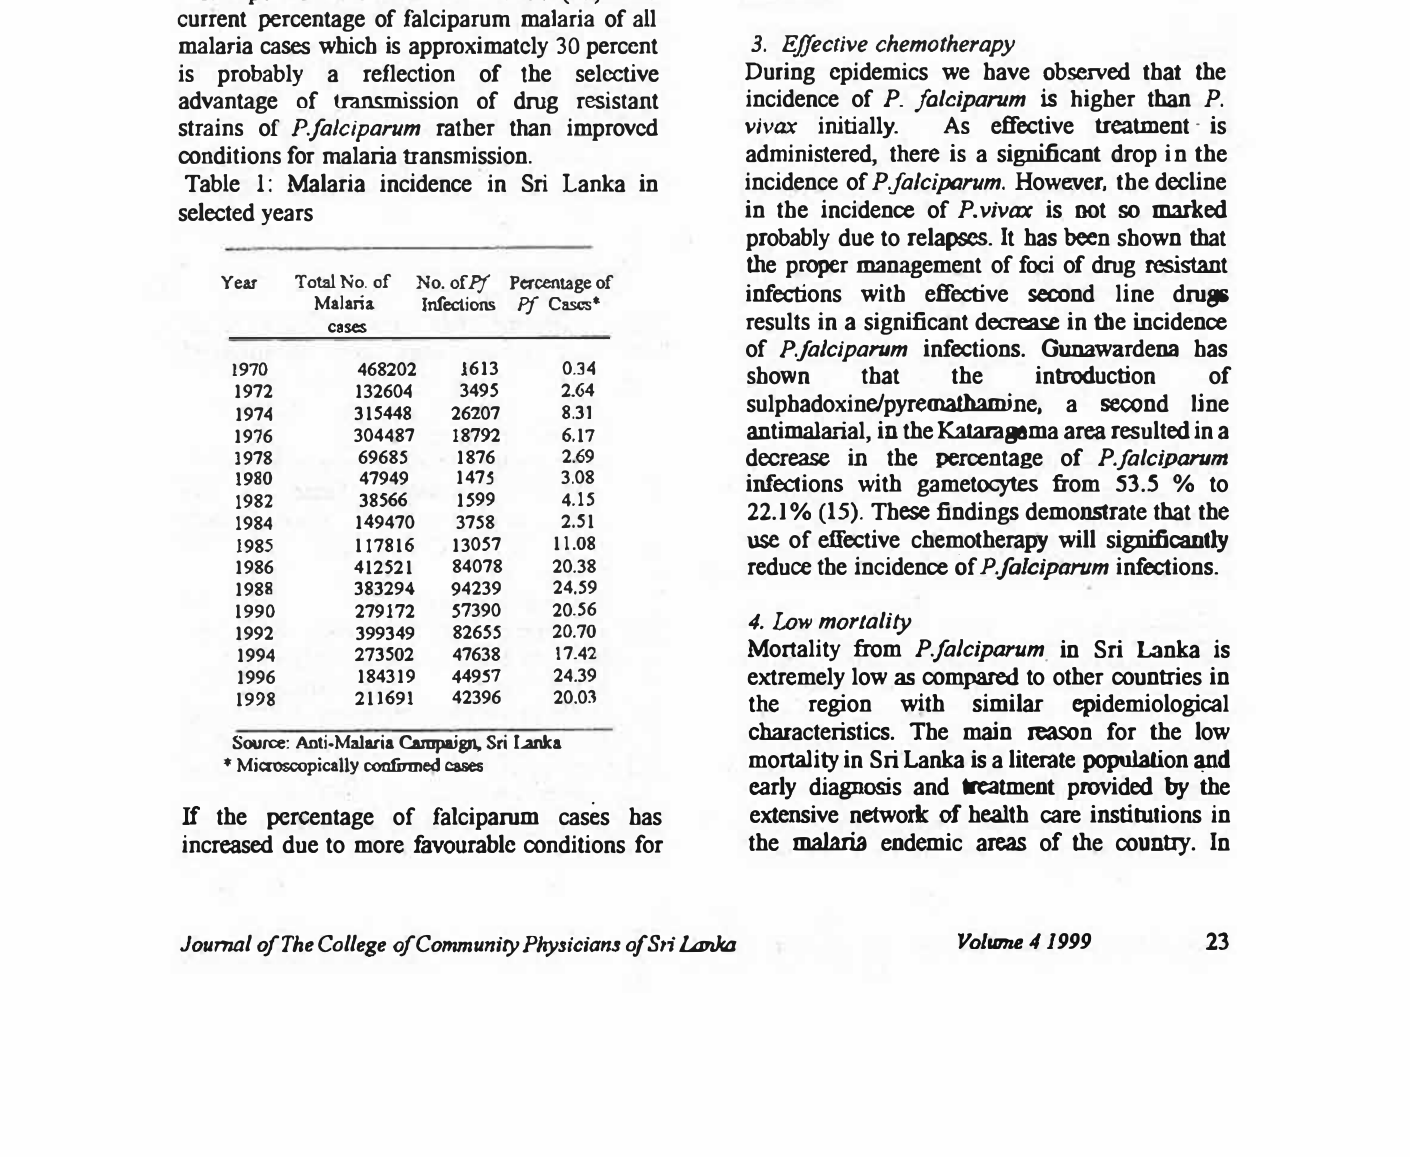
Table 1: Malaria incidence in Sri Lanka in selected